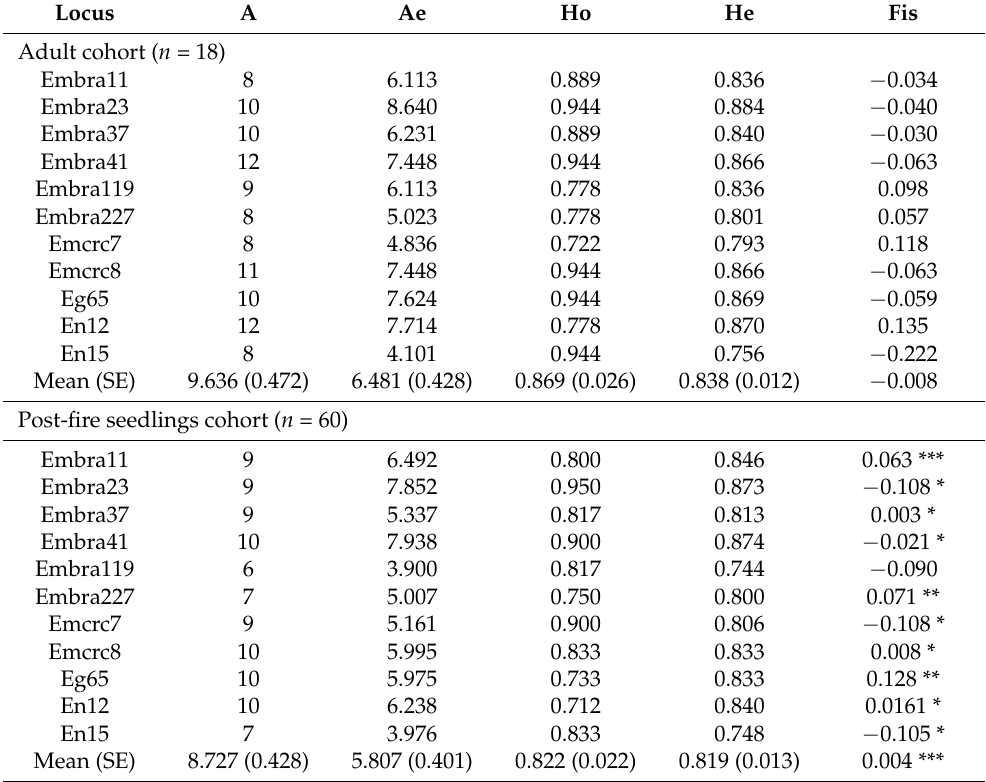
Table 2. Estimates of population size and genetic diversity measures for adult (pre-fire) individuals ( n = 18) and post-fire young seedlings ( n = 60) from Mata Nacional do Urso based on 11 microsatellite markers. Diversity indices include the number of alleles (A); the effective number of alleles (Ae); the observed and expected heterozygosity (Ho and He, respectively) and the fixation index (F IS ); SE: Standard error. t -test probability levels for HWE are * p < 0.05. ** p < 0.01. *** p < 0.001. Locus A Ae Ho He Fis Adult cohort ( n = 18)